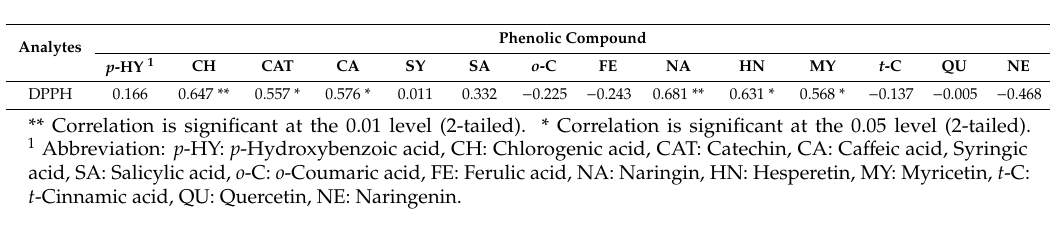
Table 7. Pearson’s correlation coe ffi cients between the antioxidant potential and phenolic compounds in S. italica